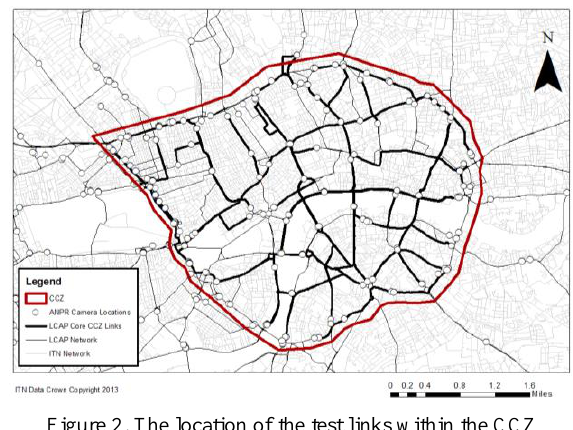
Figure 2. The location of the test links within the